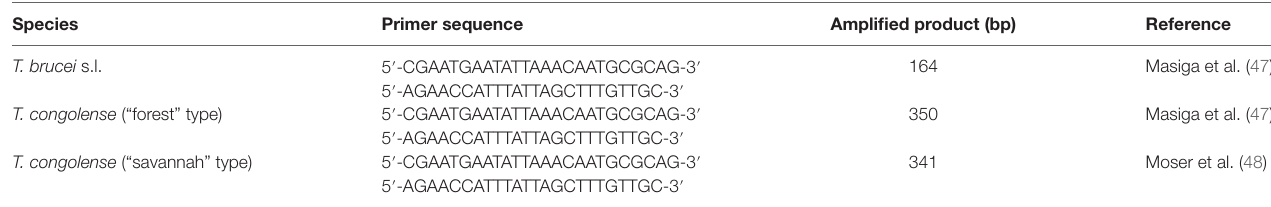
Table 1 | Primers used for PCR amplification of